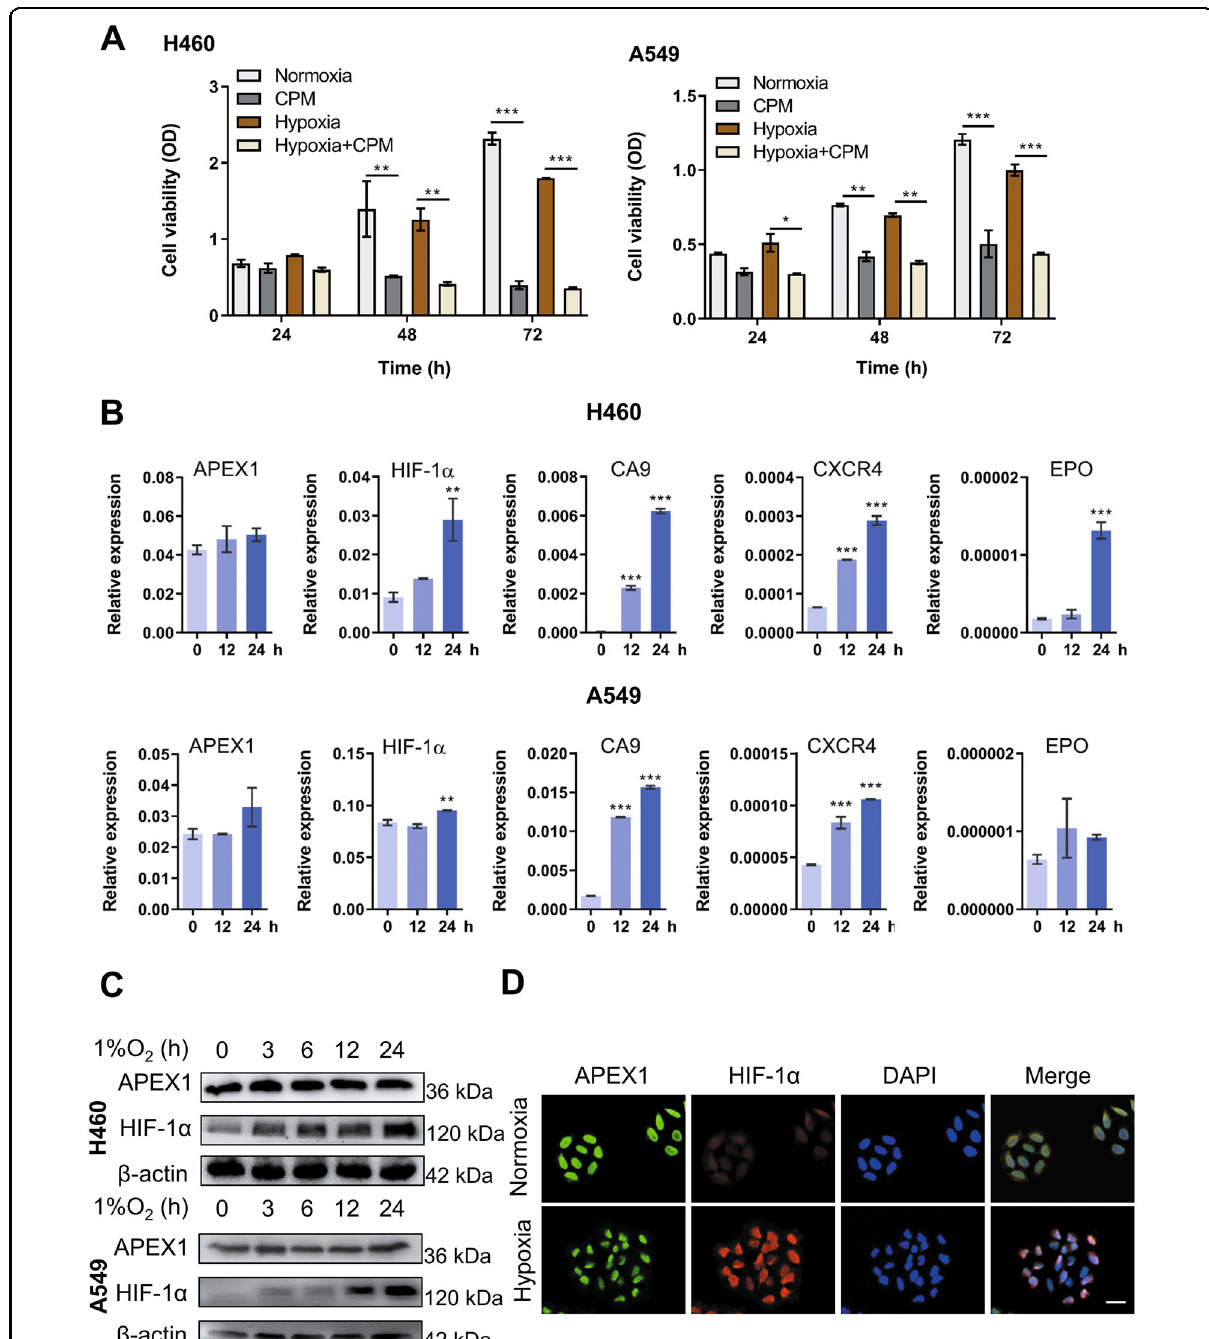
Fig. 1 Cephalomannine (CPM) inhibits cell growth and hypoxia-induced APEX1/HIF-1 α pathways in hypoxic LC cells. A H460 and A549 were treated with and without CPM under normoxia and hypoxia, and cell viability was examined at 24, 48, and 72 h. Data were expressed as mean ± SEM ( n = 3). * P < 0.05, ** P < 0.01, *** P < 0.001 compared with control cells. The results shown are representative of three independent experiments. B Hypoxia-induced APEX1/HIF-1 α pathways in LC cells in vitro. Cell lines were cultured in normoxia and 1% O 2 for 0, 12, and 24 h. HIF-1 α , APEX1, CA9, CXCR4, and EPO mRNA expression values were assessed by RT-qPCR. Gene expression is normalized to ACTB. Data were expressed as mean ± SEM ( n = 3). * P < 0.05, ** P < 0.01, *** P < 0.001 compared with control cells. C H460 and H1299 cells were incubated in 1% O 2 for 0, 12, and 24 h. Protein levels of HIF-1 α and APEX1 were determined by western blotting. β -Actin were used as a control for western blots. n = 3. D H460 cells were cultured under hypoxia. APEX1 (green), HIF-1 α (red), DAPI (blue) staining, and 3-channel merged images indicated the nuclear colocalization of HIF-1 α . Scale bars, 50 μ m. Data presented are representative of three independent